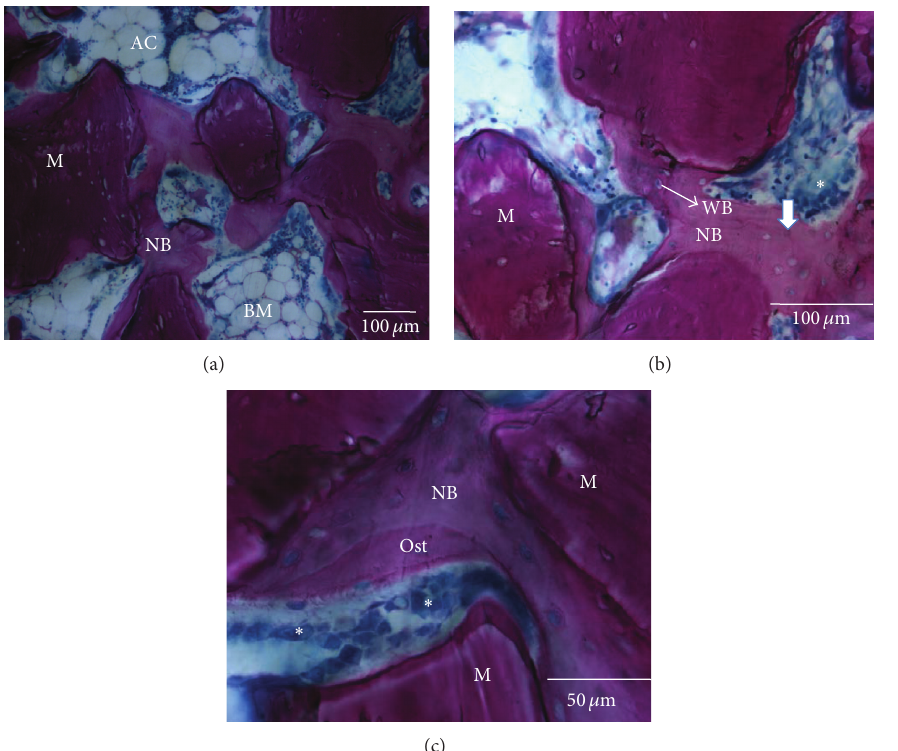
Figure 2: Representative light micrographs illustrating histological details of a defect grafted with DBBM at 6 weeks after implantation. DBBM (M) surrounded and bridged by newly formed bone (NB). The increased number of adipocytes (AC) in the wide marrow spaces (BM) indicates bone marrow maturation ((a); magnification × 10). Woven bone (WB) and mature paralleled-fiber bone (arrows) were observed ((b); magnification × 20). Osteoblast-lining cells (asterisks) on the osteoid surface (OST) indicate ongoing bone formation ((b); magnification × 20 and ((c); magnification × 40). Stain: